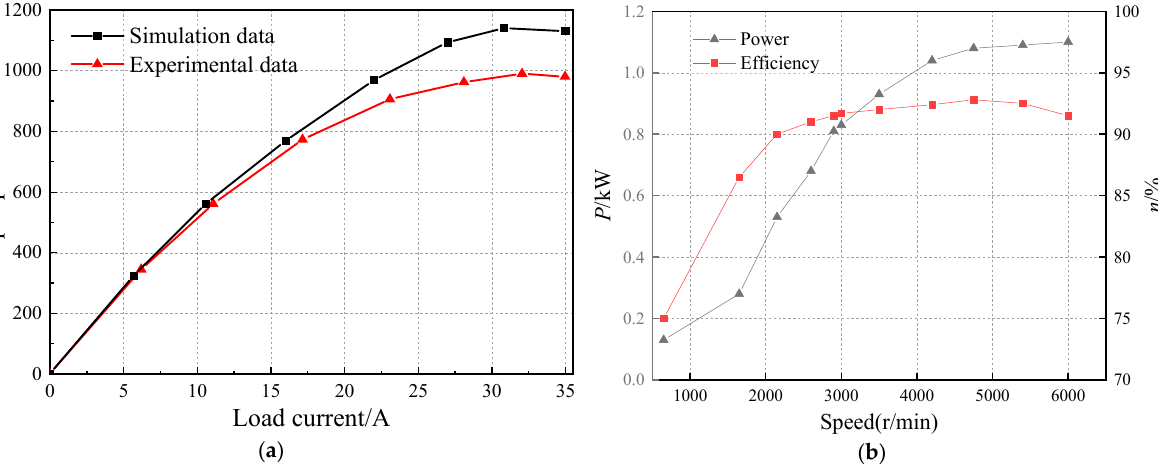
Figure 27. Generator output power and efficiency change curve. ( a ) The output power varies with the load current; ( b ) curve of power and efficiency with generator speed.